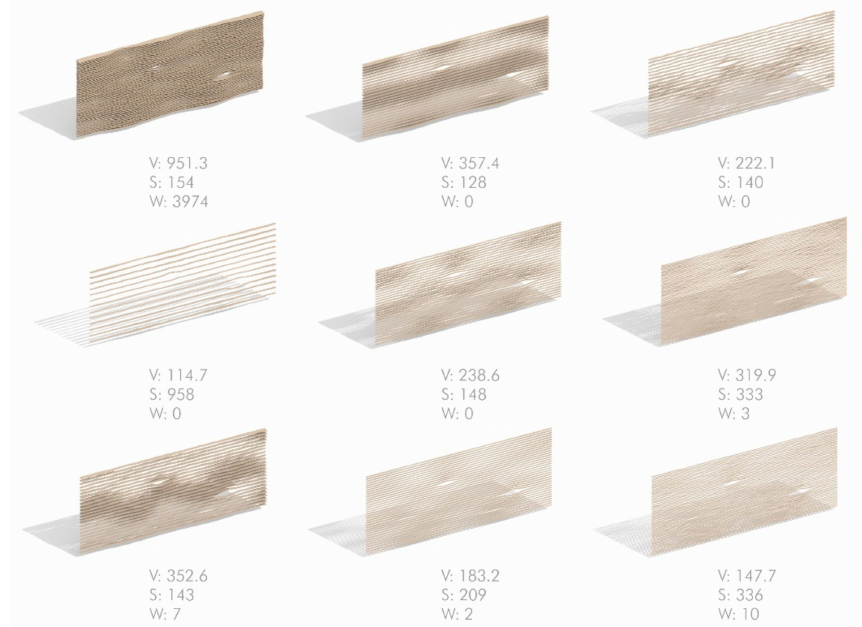
Figure 12. Visual comparison between the design